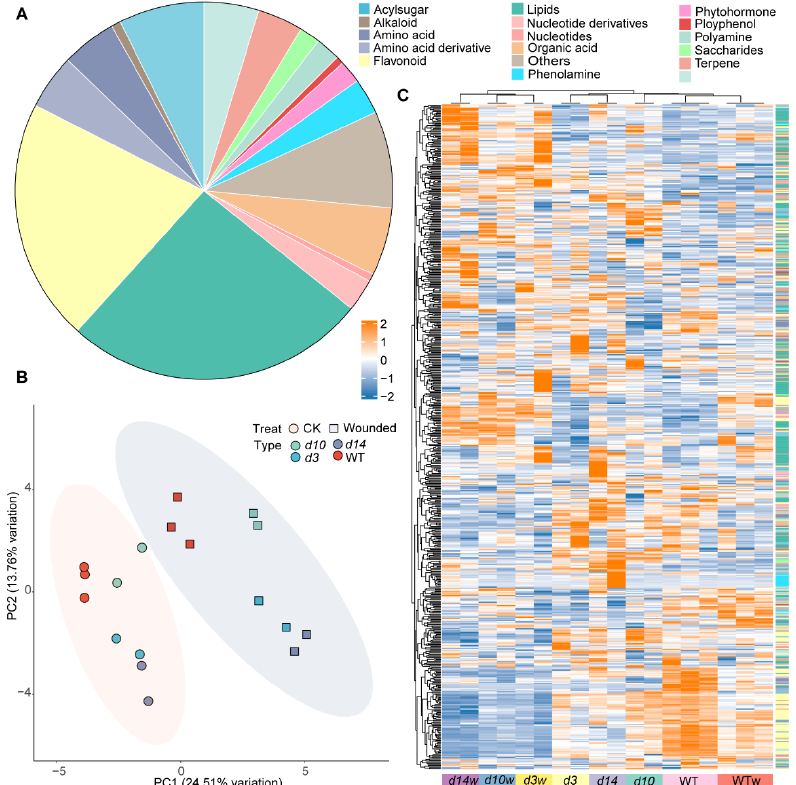
Figure 1. Metabolomic analysis of the SLs mutants and wild-type (WT) plants before and after wounding. ( A ) A total of 615 metabolites were detected in this study. ( B ) Principal component analysis (PCA) and ( C ) heatmap of the 615 metabolites in SLs mutants ( d10 , d3 , and d14 ) and wild-type plants. PC1 and PC2 refer to the first and second principal components, respectively. WT means wild type; d3 , d10 , and d14 represent mutants of DWARF3 , DWARF10 , and DWARF14 , respectively. WTw, d3w , d10w , and d14w samples were collected 0.5 h after wounding. Next, we identified differentially accumulated metabolites (DAMs, |log 2 fold change (FC)| ≥ 1 and p -value < 0.05) upon wounding. In total, 51, 44, 59, and 35 wounding-re-